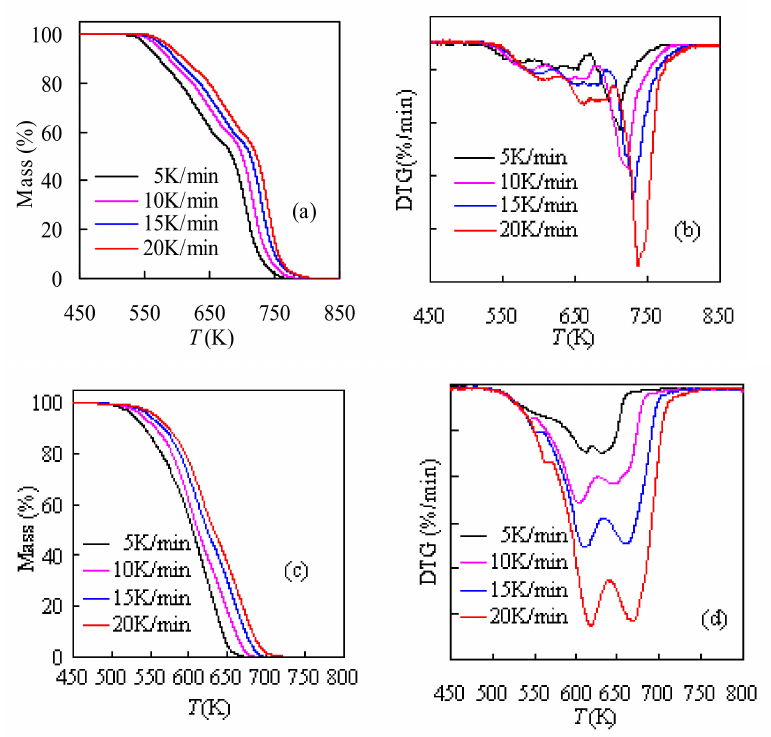
Figure 3. TGA and DTG results determined for TSPU ( a , b ) and WPU( c , d